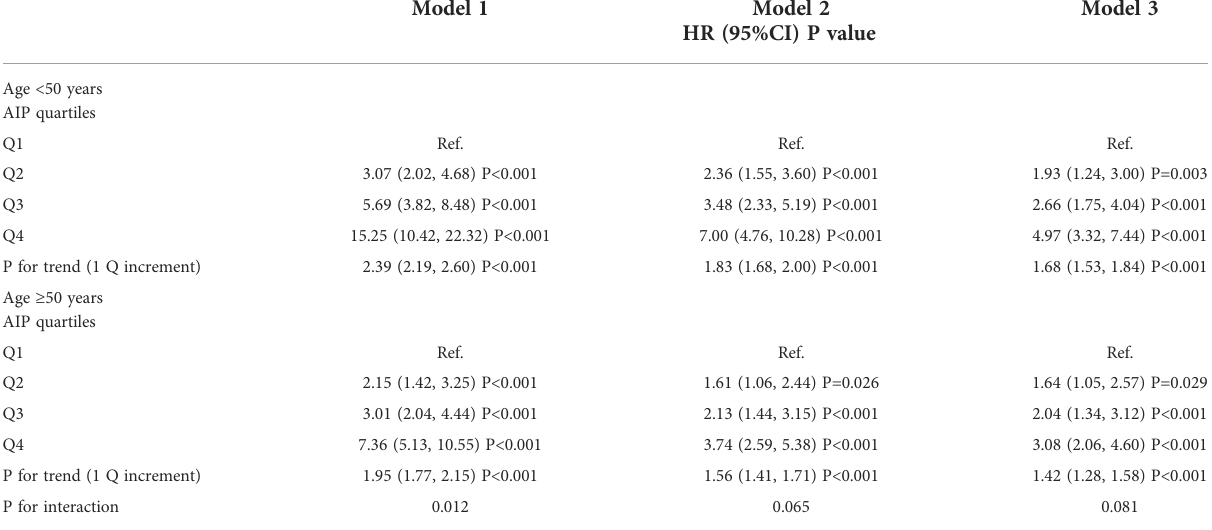
TABLE 4 Association between AIP and new-onset NAFLD in different age groups in female